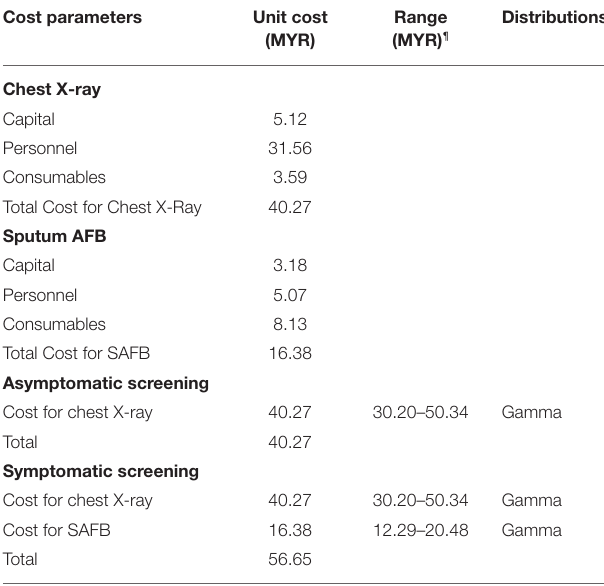
TABLE 4 | Cost input